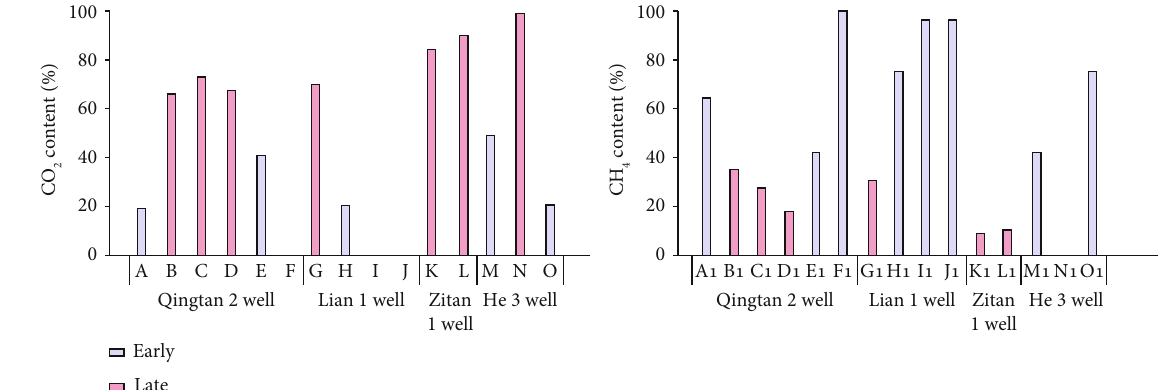
and CH contents compositions of early and late organic inclusions between He 8 section and Shan 1 2 4